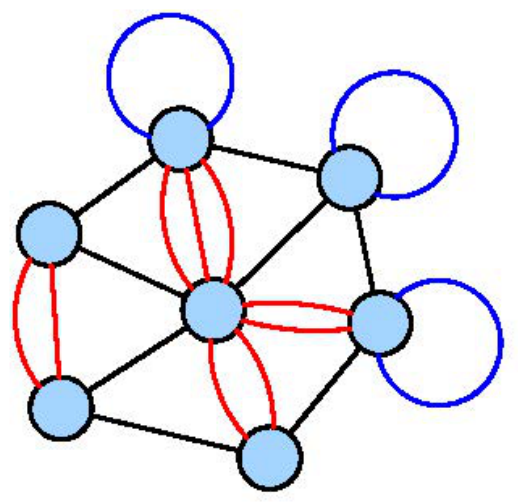
Figure 47: A multigraph with multiple edges ( red ) and several loops ( blue ).